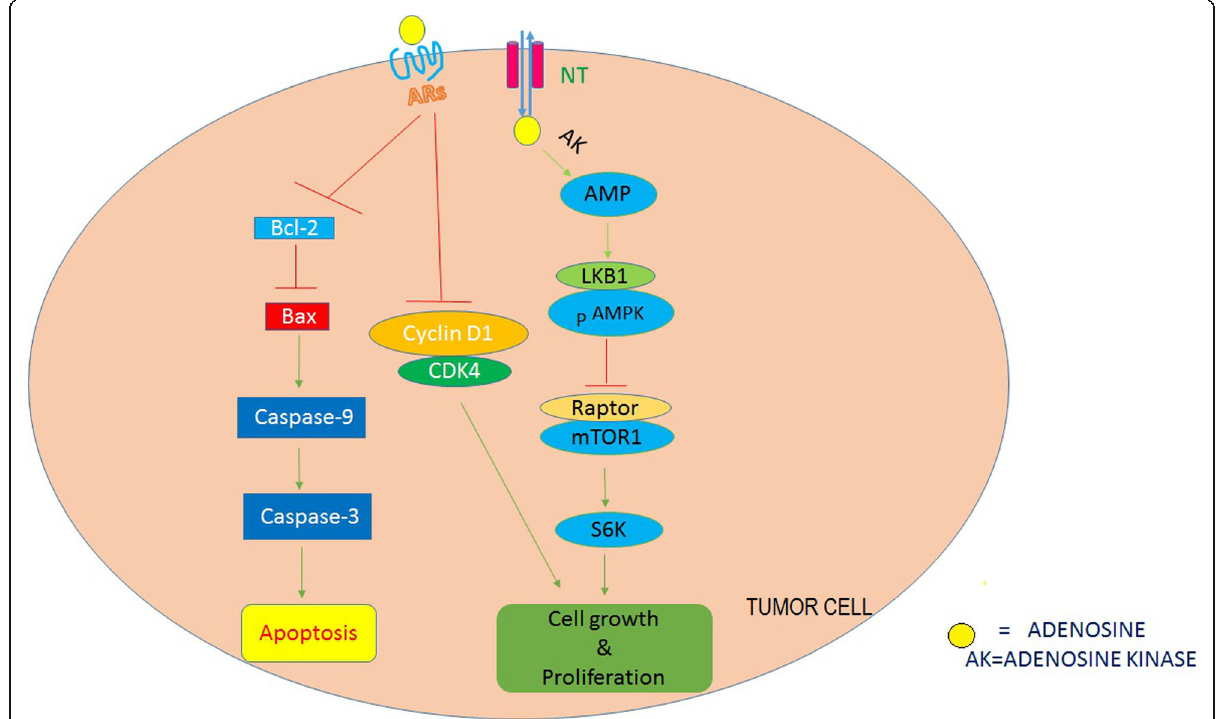
results in cell growth arrest and enhanced cytotox- icity. Resistance to platinum-based chemotherapy is one of the major problems faced while treating the OC cases. Platelets are involved in the induction of tumour progression and chemoresistance. Platelet- tumour cell interaction through P2Y may lead to 12 EMT during cancer progression. This reveals the im- portance of using P2Y receptor antagonists in the 12 treatment of cancer. Purinergic molecules are dynam- ically positioned in cancer immunity, and targeting this pathway could efficaciously suppress tumour pro- gression and metastasis and can be used as the best therapeutic target in OC.